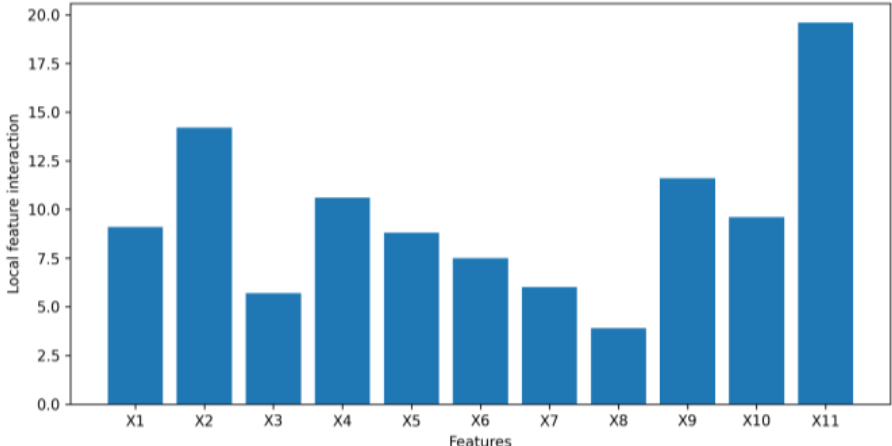
Figure 19. Local feature interaction values for dataset 3.